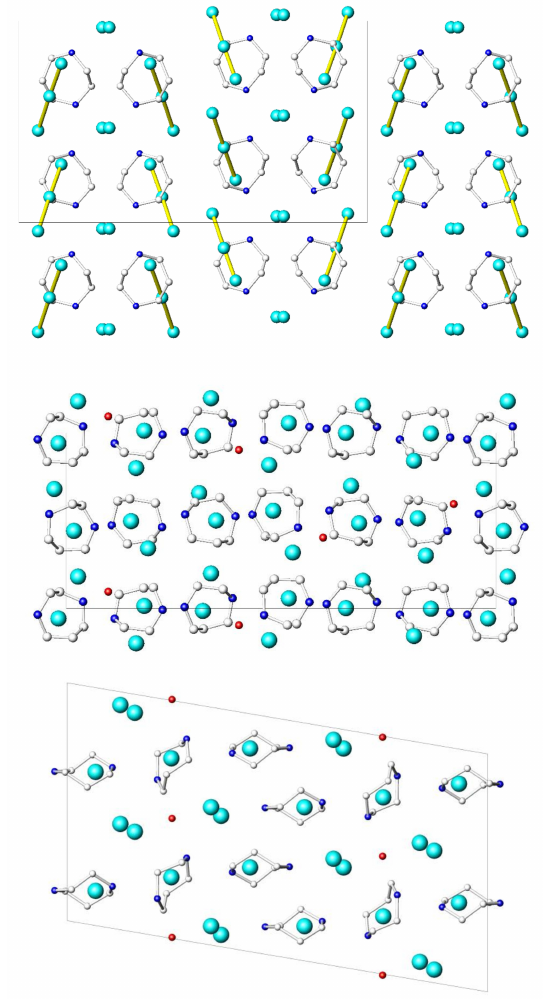
Figure 3. Projections of the crystal structures of (HpipeH 2 )I(I 3 ) on the [010] plane (top), (HpipeH 2 ) 3 I 6 · H 2 O on the [100] plane (middle), and (HpipeH 2 ) 3 (H 3 O)I 7 on the [010] plane (bottom). Iodine, cyan; oxygen, red; nitrogen, blue; carbon, light gray. Hydrogen atoms are omitted for clarity. Black lines show unit